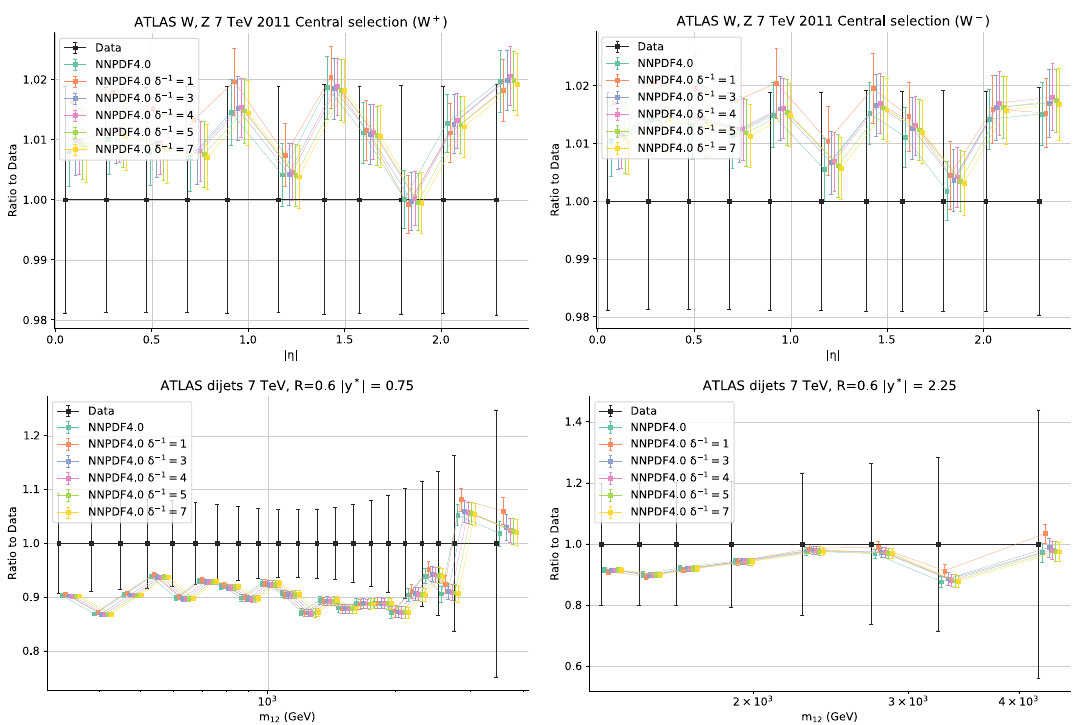
Fig. 5 Data–theory comparison for the W ± subset of the ATLAS W , Z 7 TeV CC measurement [15], as a function of the absolute lepton rapidity η (top), and for two bins in the absolute rapidity difference between the two leading jets | y ∗ | of the ATLAS dijets R=0.6 7 TeV measurement [24], as a function of the di-jet invariant mass m 12 . The- oretical predictions are obtained with the NNPDF4.0 baseline parton